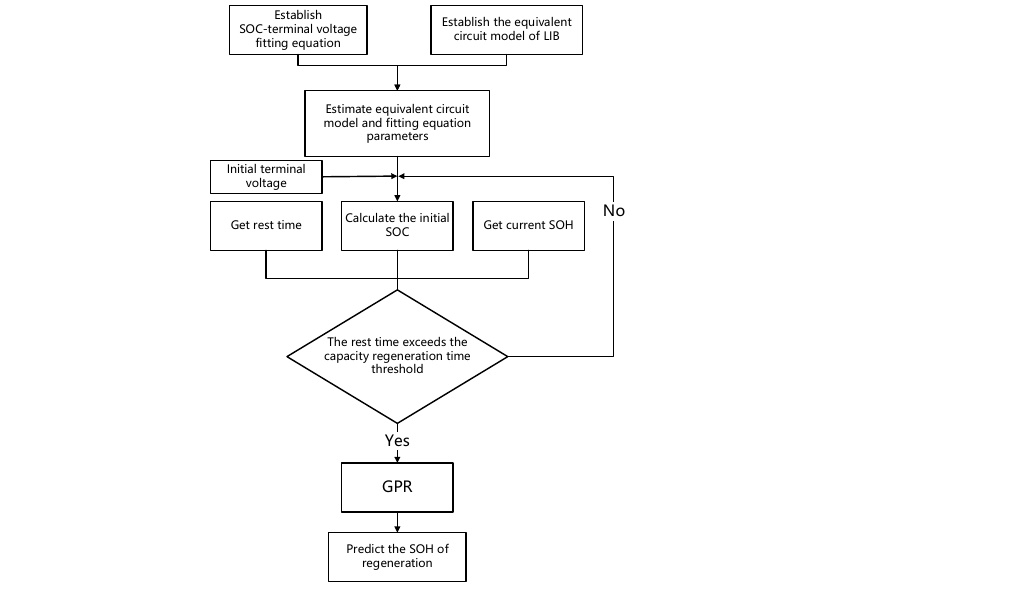
Figure 3. Flow chart for predicting the state of health of regeneration.